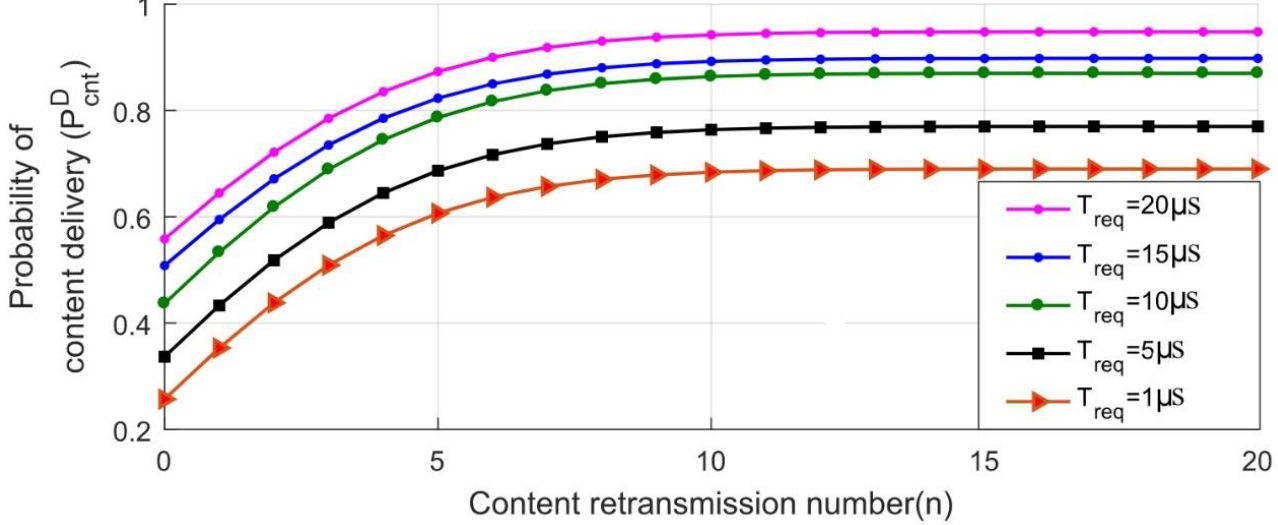
Figure 8. Probability of content delivery on localhost MQTT server over Virtual Machine for content interval ( T cnt ).